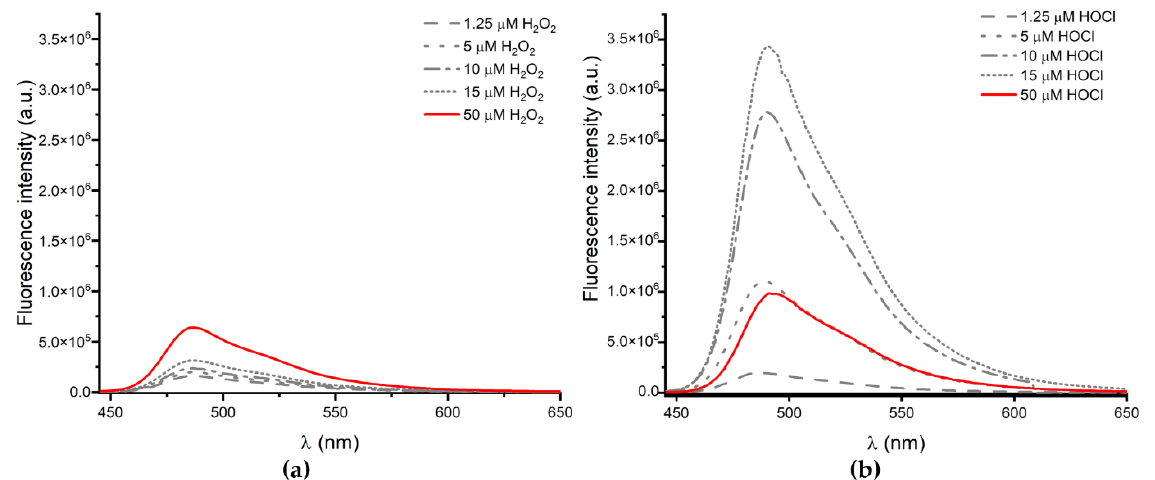
Figure 5. Emission spectra of the BC-BE probe (5 µM, λ ex = 442 nm) recorded before and after bolus addition of different amount (0, 1.5, 4.5, 6, 7.5 µM) of: ( a ) H 2 O 2 (after 24 h of incubation); ( b ) HOCl (after 30 min of incubation). Tests were conducted in aqueous solutions containing EtOH (10%), phosphate buffer (0.1 M, pH 7.4) and dtpa (10 µM).